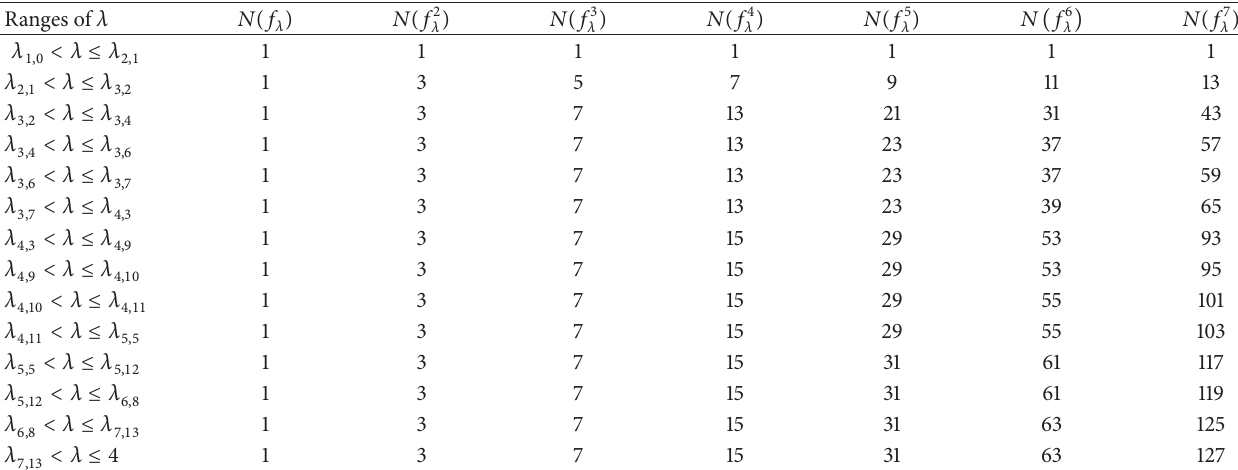
Table 1: The number of forts of 𝑓 𝑖 , 𝑖 = 1, 2,. . . , 7 .